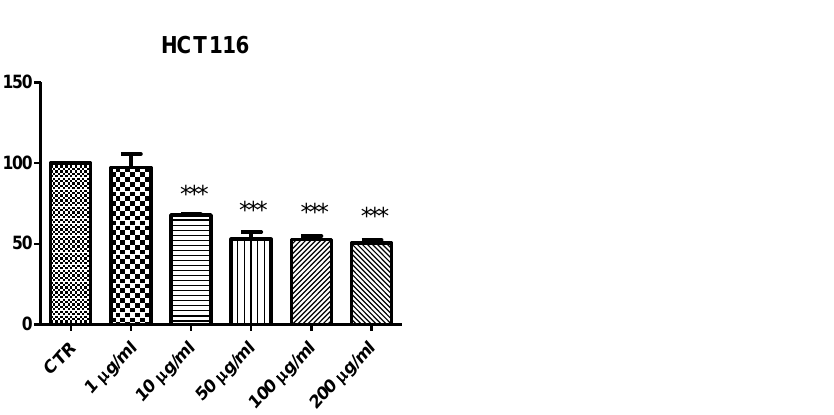
Figure 1. Antiproliferative effect induced by Bridelia ferruginea methanolic extract (1–200 µg/mL) against human colon cancer HCT116 cell line. ANOVA, p < 0.0001, *** p < 0.001 vs. Control (CTR) group.